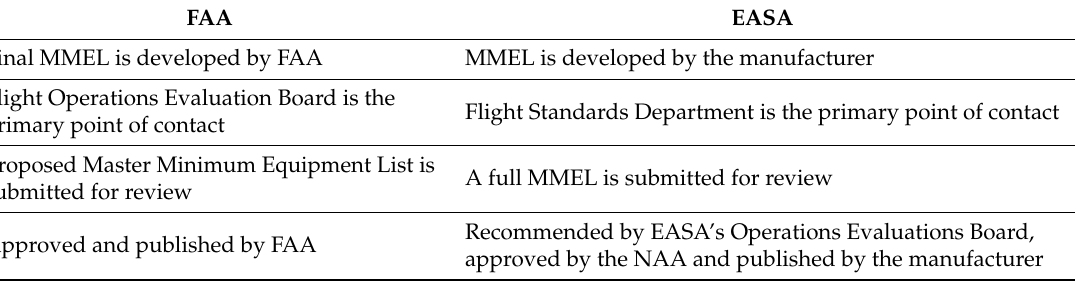
Table 1. Di ff erences between the Federal Aviation Authority (FAA) and the European Aviation Safety Agency (EASA) MMEL development and approval [5,9–11]. FAA EASA Final MMEL is developed by FAA MMEL is developed by the manufacturer Flight Operations Evaluation Board is the Flight Standards Department is the primary point of contact primary point of contact Proposed Master Minimum Equipment List